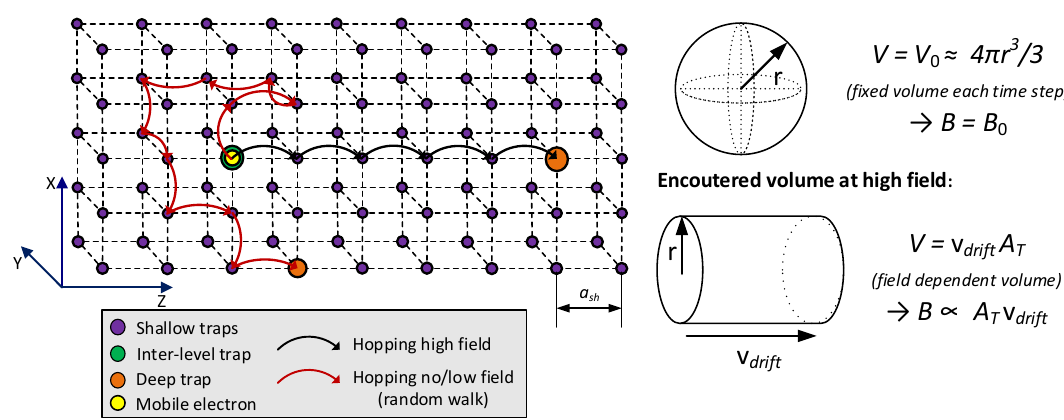
Figure 3. Schematic representation of the concept of trapping and detrapping. For sake of simplicity, shallow, inter-level and deep traps are assumed to be placed in a shared cubic lattice. Lattice spacing is dependent on shallow trap density only as N 0 deep << N 0 int << N 0 shallow . Two deep traps are shown within the shallow trap lattice for illustration purposes. Volumes encountered by the mobile carrier at each time step are shown at low and high fields, from which the number of encountered traps, and thereby trapping rates, can be deduced.